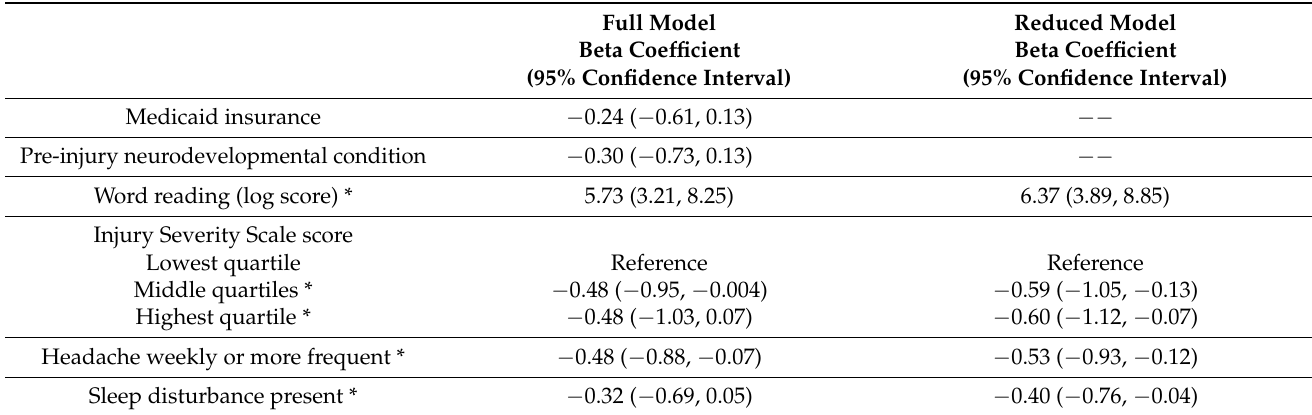
Table 5. Multiple linear regression analysis of Neurocognitive Index